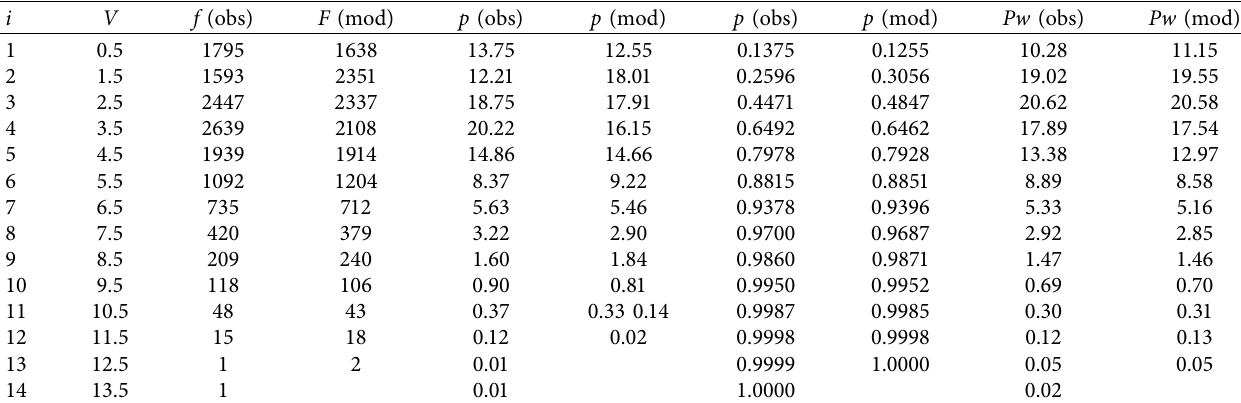
Figure 5: Histogram of wind speed distribution (bar) and Weibull function (line) at Bac Lieu station for (a) observation and (b) simulation. Table 2: The Weibull parameters and wind power density for observation and simulation at Bac Lieu station. Parameter Observation Simulation Average wind speed 3.3 Weibull shape parameter (k) Wind power density Table 3: Observed and simulated wind data frequency and probability density calculated from the Weibull function at Bac Lieu